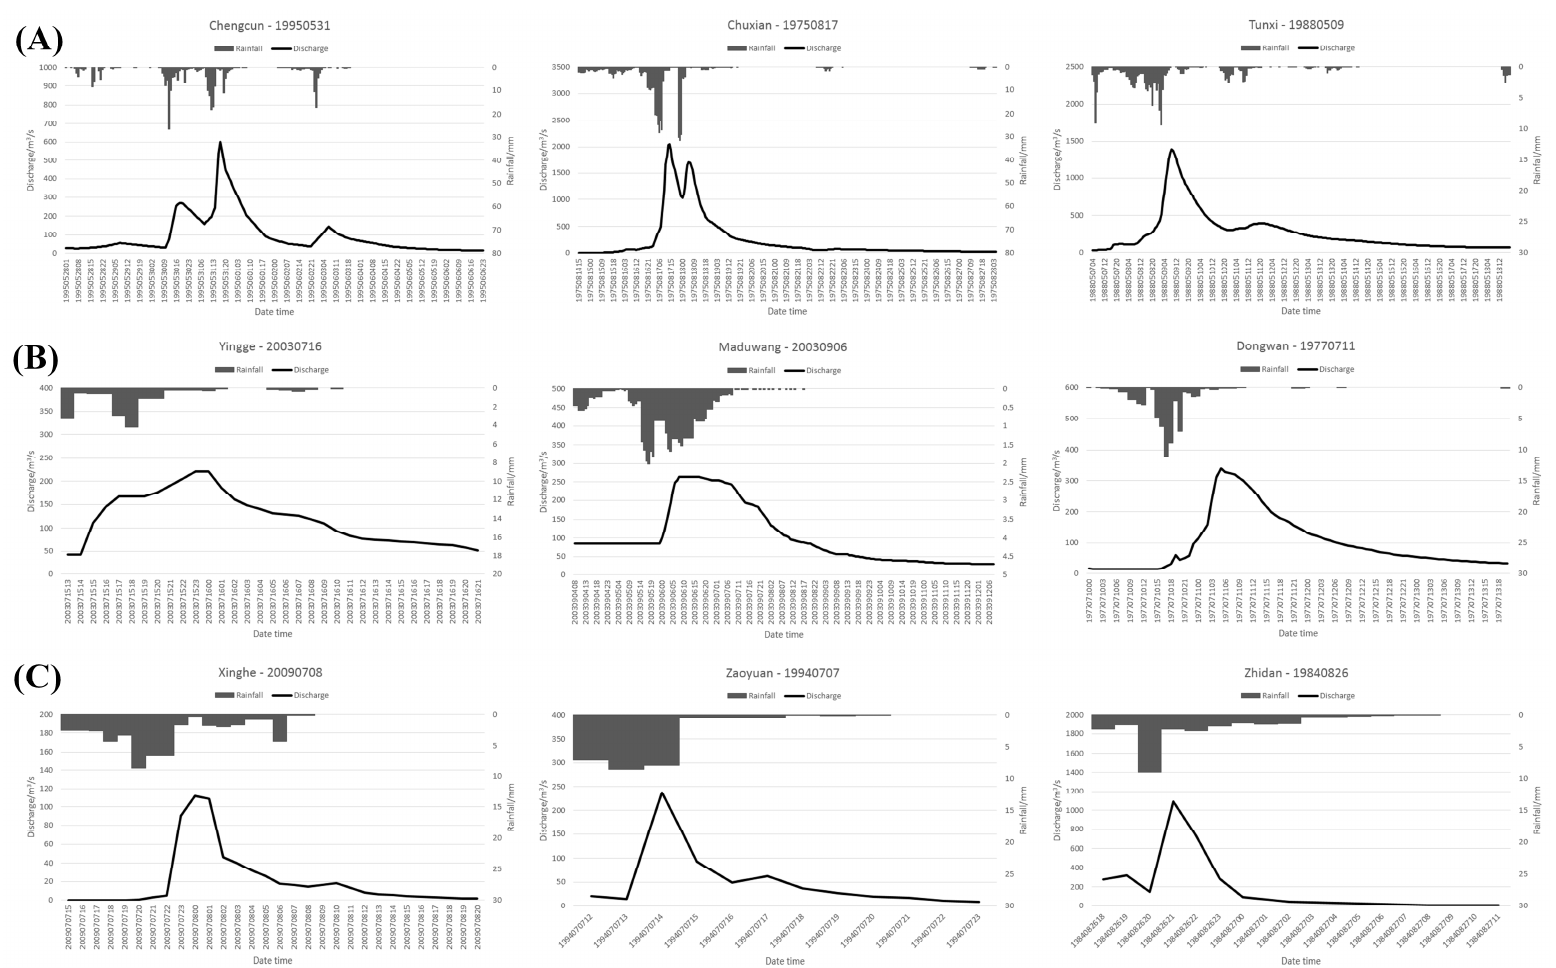
Figure 13. Typical measured hydrographs of the 9 study watersheds. ( A ) Typical hydrographs of humid watersheds such as Chengcun, Chuxian, and Tunxi; ( B ) Typical hydrographs of semi-humid semi-arid watersheds such as Yingge, Maduwang, and Dongwan; ( C ) Typical hydrographs of arid watersheds such as Xinghe, Zaoyuan, and Zhidan.